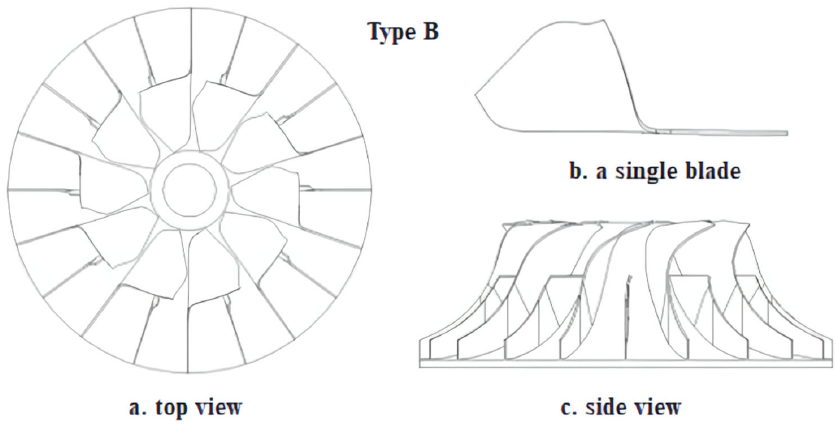
Figure 6. Blade configuration of type B.